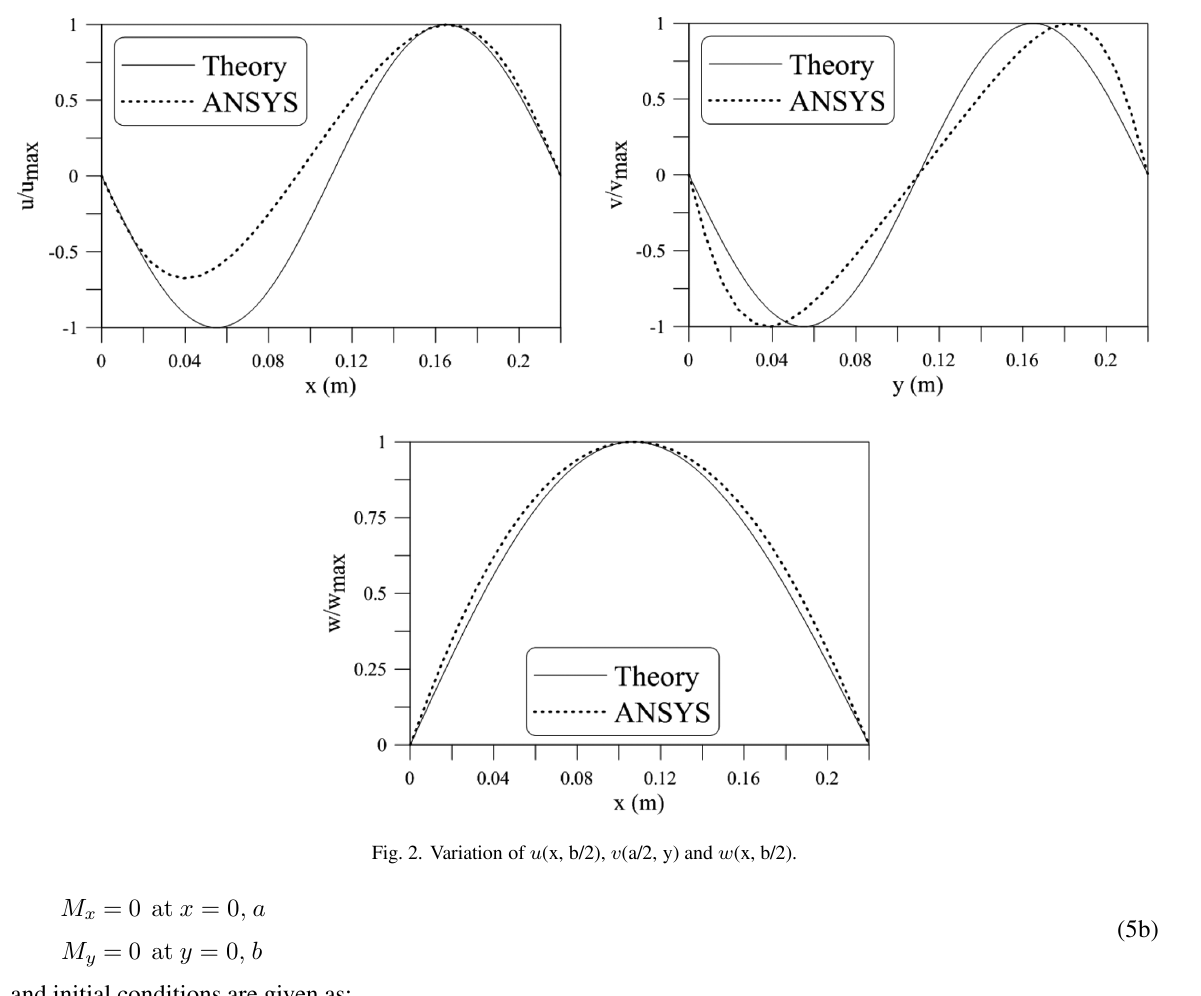
Fig. 2. Variation of u (x, b/2), v (a/2, y) and w (x,